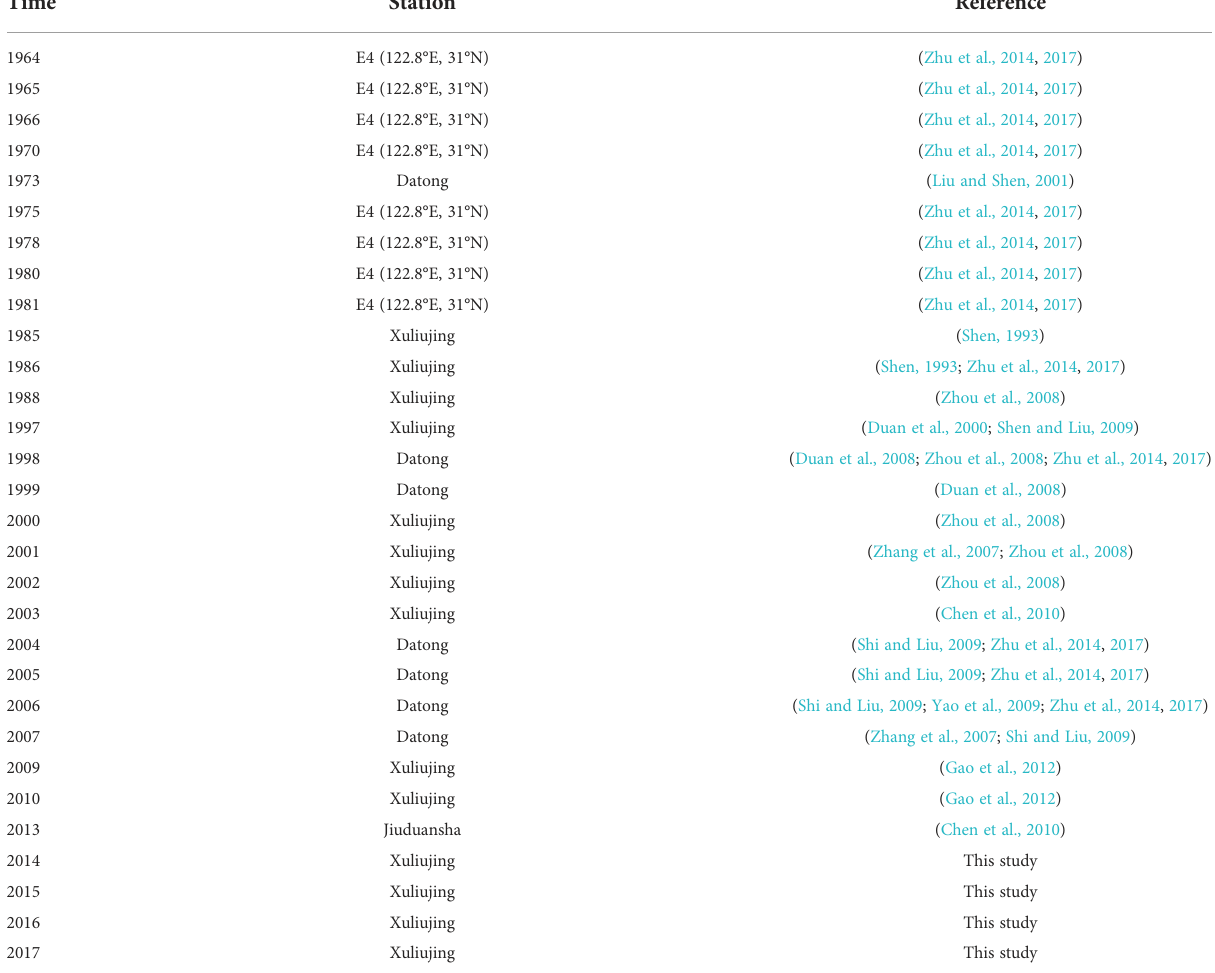
TABLE 1 Different sources of nutrient data collected from 1960 to 2018. Time